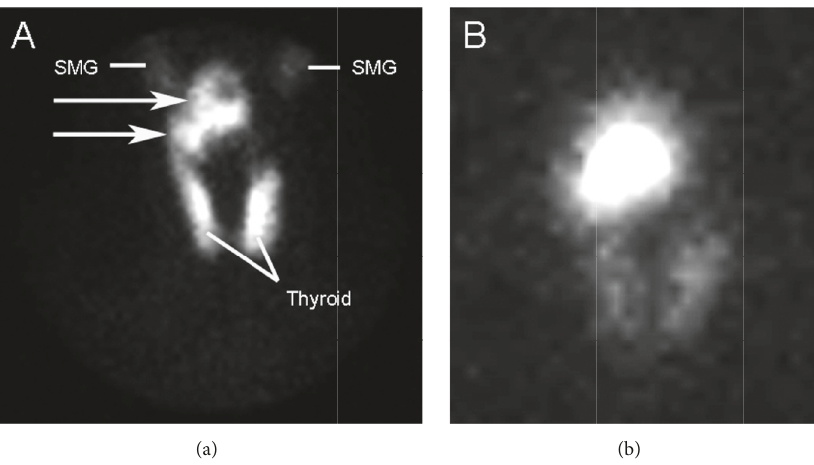
Figure 1: (a) Anterior view from initial 99 m Tc-pertechnetate thyroid scan. There is heterogeneous uptake in a lobulated mass (arrows) superior to the right lobe of the thyroid. Uptake in the thyroid gland is relatively homogeneous. There is normal physiologic uptake in the submandibular glands (SMG). 131 Iodine scan (b) demonstrates intense radioiodine uptake in the mass.